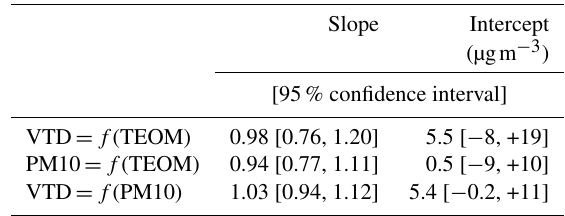
Table D2. Optimal slope and intercept using orthogonal regres- sions, excluding the heavy loaded sample.